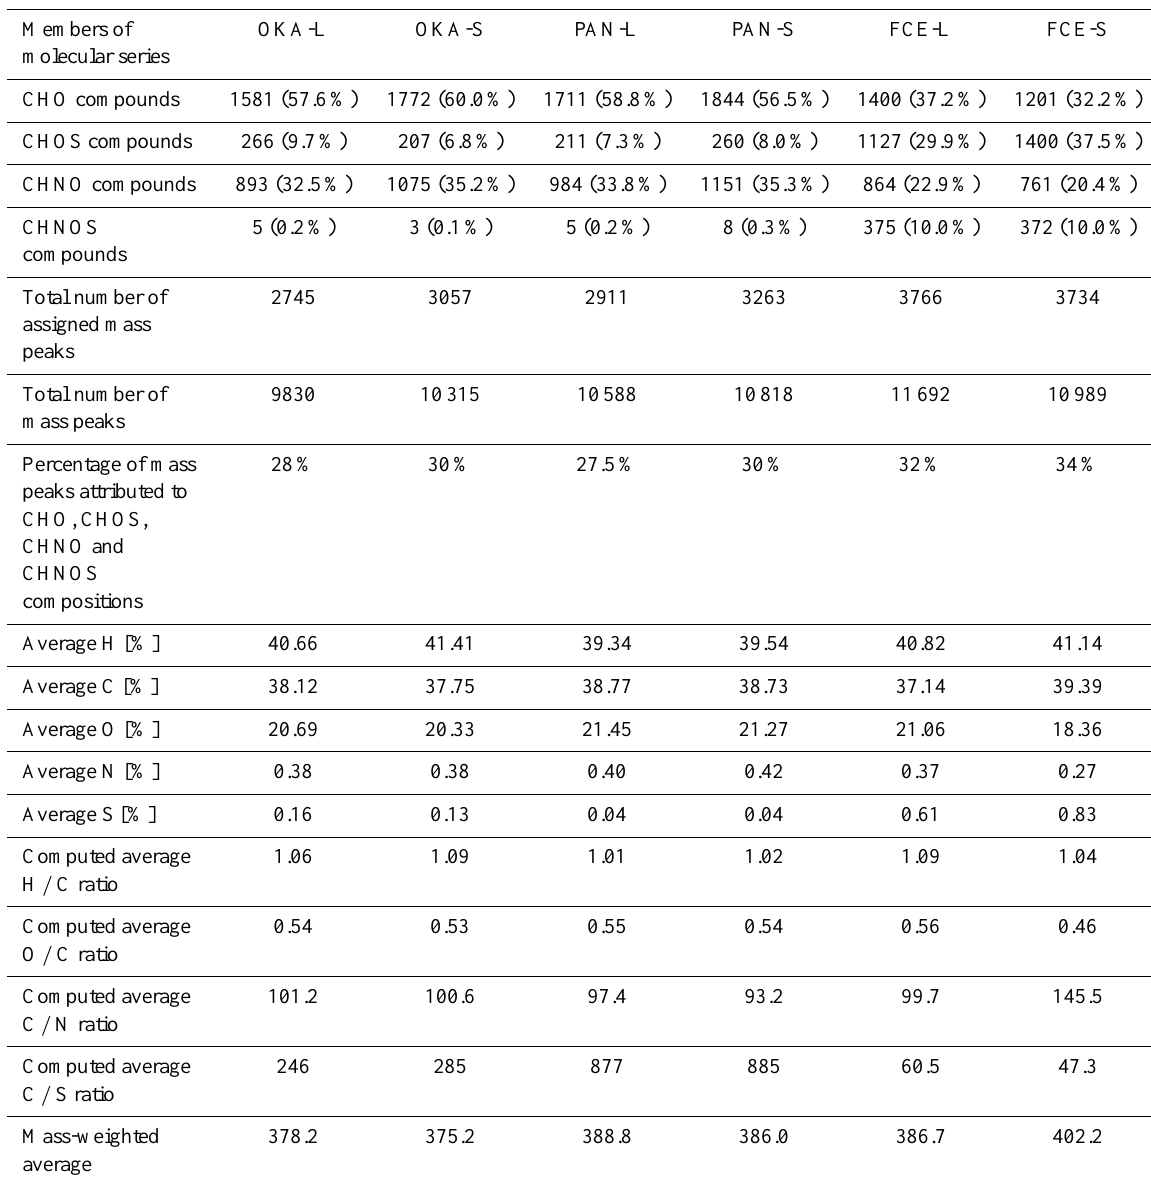
Table 3. Counts of mass peaks in wetland SPE-DOM as computed from negative electrospray (ESI) 12T FTICR mass spectra for singly charged